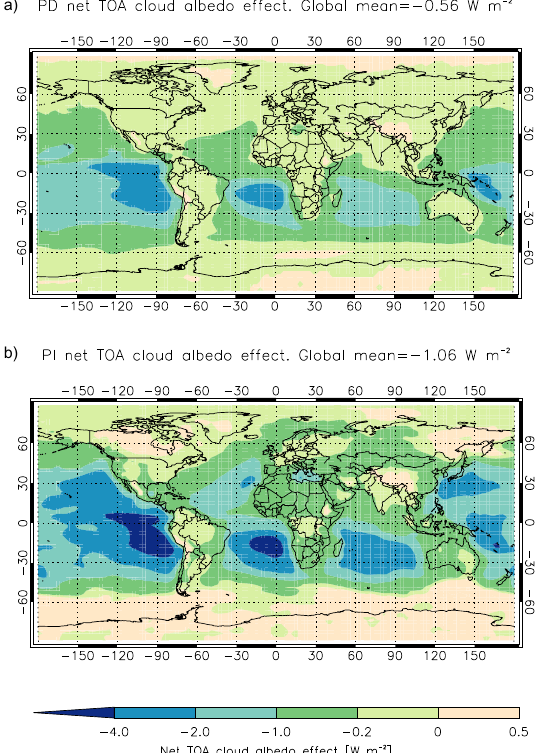
Fig. 7. Annual mean cloud albedo effect due to volcanic degassing using the Andres and Kasgnoc (1998) inventory in relation to the simulations where volcanic emissions were omitted. The cloud albedo effect is calculated at the top of the atmosphere (TOA) for low- and mid-level cloud changes (i.e. up to 600hPa) for both pre- industrial (PI) and present-day (PD) atmospheric